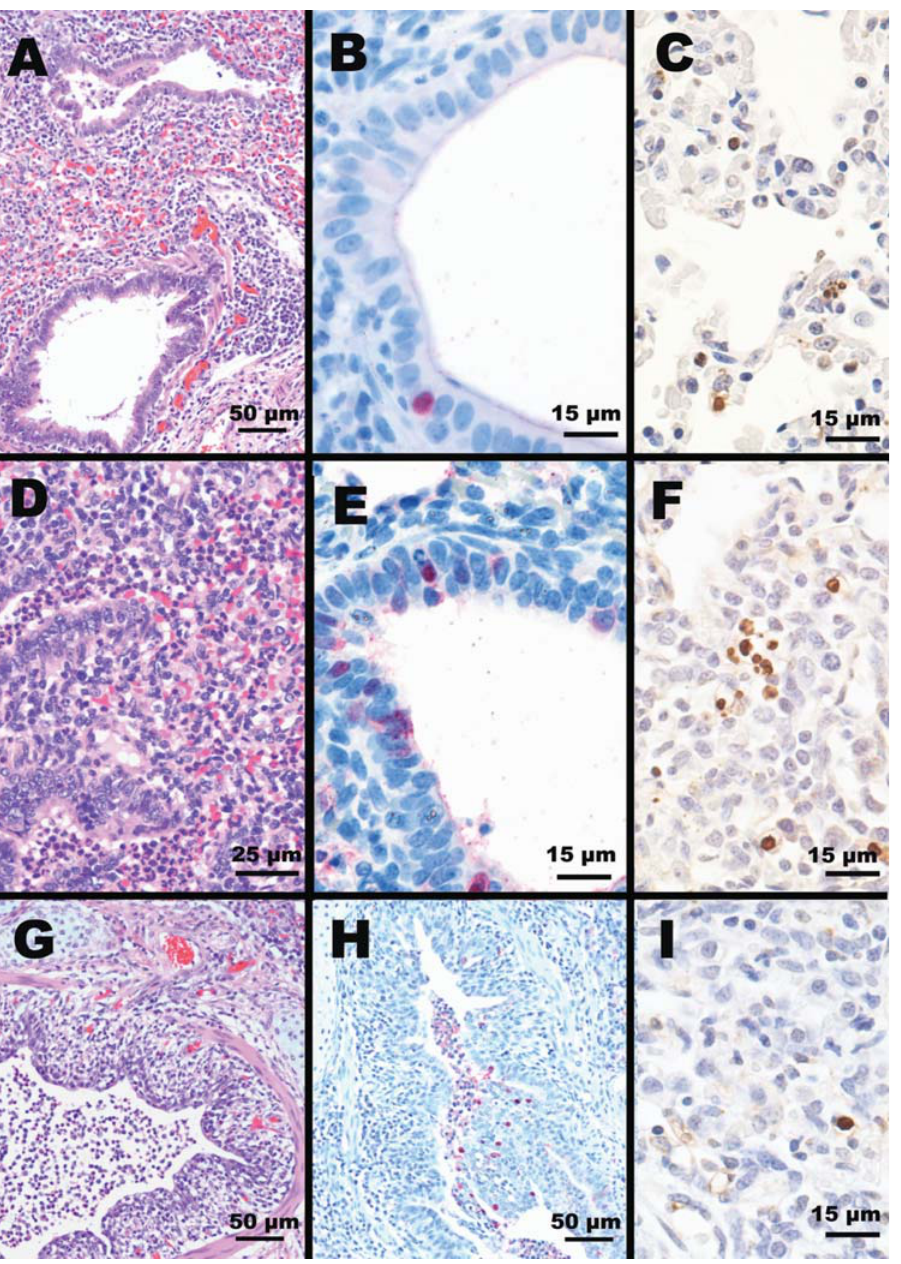
Figure 5. Histopathologic findings in lungs of pigs on day 5 after virus inoculation. ( A ) Moderate lymphocytic bronchiolitis with slight intra-luminal cellular debris (HE staining) and ( B ) viral antigen reaction in a single bronchiolar cell (IHC staining) in the lungs of pigs infected with VN/ 04 (H5N1) virus. ( D ) Moderate bronchioalveolitis with moderately cellular debris in the airway of bronchioles and alveoli (HE staining) and ( E ) marked viral antigen reaction in bronchiolar cells (IHC staining) in the lungs of pigs infected with WS/Mong/05 (H5N1) virus. ( G ) Severe bronchitis characterized by degeneration and necrosis of bronchi epitheliums with severe intra-luminal cellular debris (HE staining) and ( H ) prominent viral antigen reaction in the bronchial epitheliums and necrotic cellular debris (IHC staining) in the lungs of pigs infected with Sw/NC/88 (H3N2) virus. Apoptosis frequently observed in proliferating leukocytes and macrophages in the lungs of pigs infected with ( C ) VN/04 and ( F ) WS/Mong/05 H5N1 viruses (TUNEL assay). ( I ) TUNEL assay of lungs from pig infected with Sw/NC/88 (H3N2) virus–a single cell affected with apoptosis.